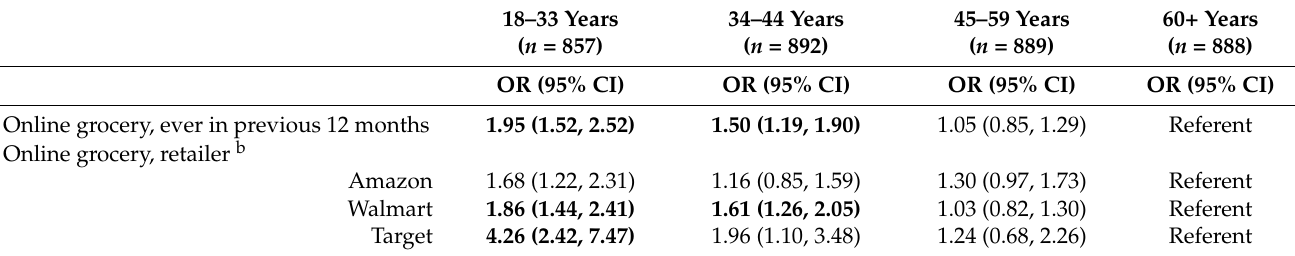
Table 4. Model-based associations between age groups a and self-reported online grocery shopping behaviors and